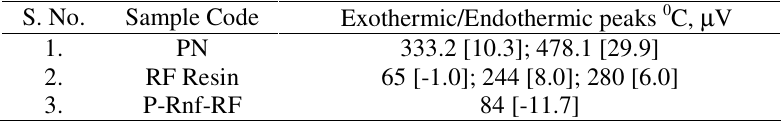
Table 5. Differential thermal analysis of PN, RF and P-Rnf-RF